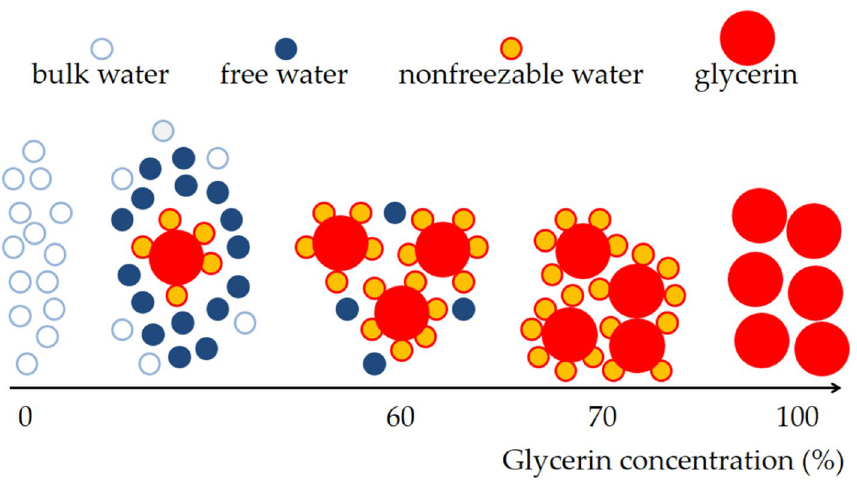
Figure 6. A schematic diagram to illustrate the microstructure type of the water in the glycerin solutions with various